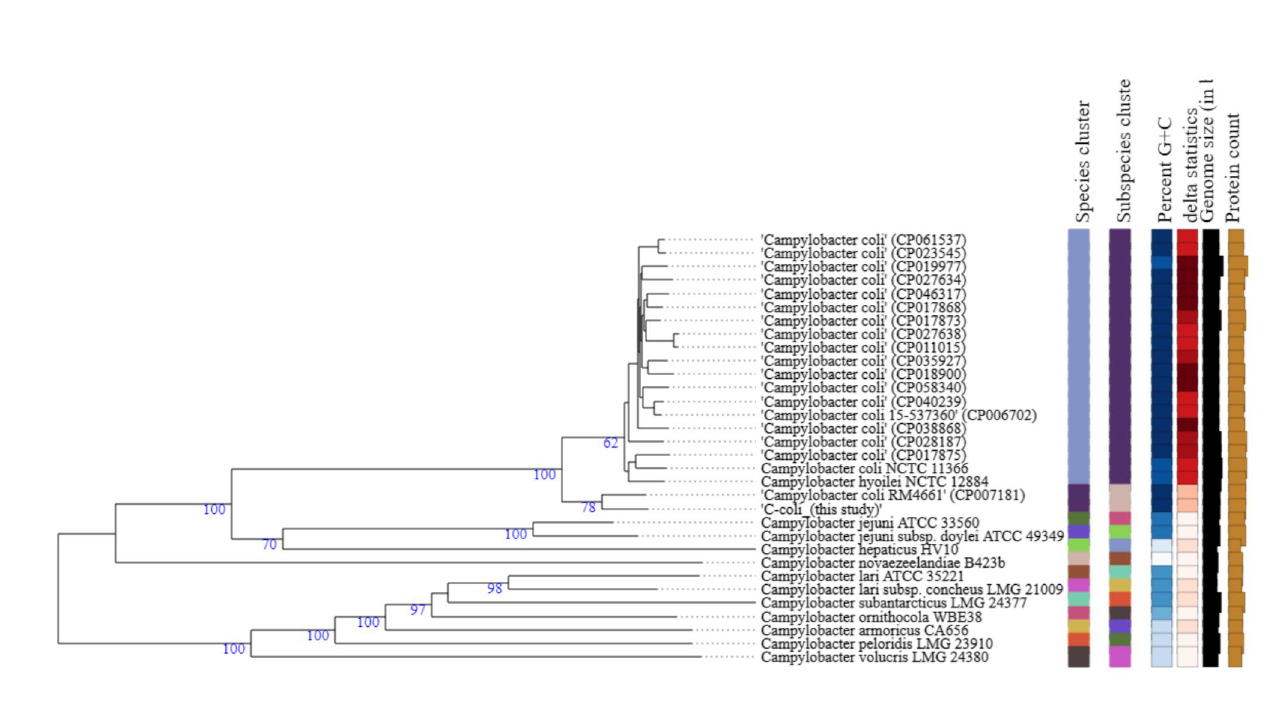
Figure 2. Type (Strain) Genome Server (TYGS) result for C. coli strain 200606 dataset. Tree was generated as for C. jejuni . Percent G+C (27.39–31.5); δ statistics (0.137–0.295); protein content